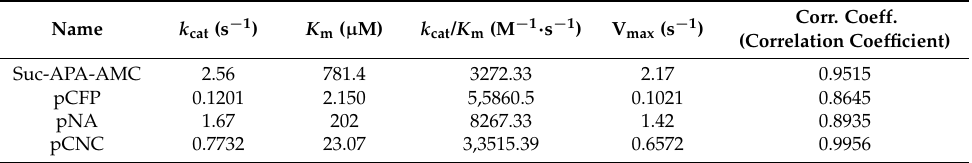
Figure 5. The response curves of 2 mg of pCFP (blue), pNA (pink), and pCNC (green) biosensor upon detection of 7-amino-4-methylcoumarin released with HNE at 0.5 U/mL substrate hydrolysis at 37 °C. Table 2. Kinetic parameters for human neutrophil elastase (HNE) catalyzed hydrolysis of the tripeptide in solution and on the sensor.